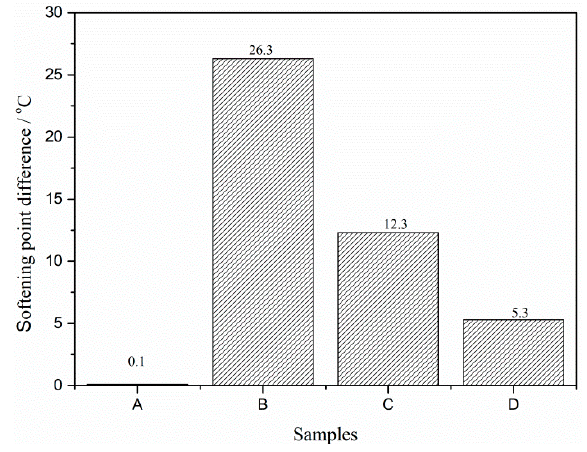
Figure 7. Softening point difference of asphalt binders .